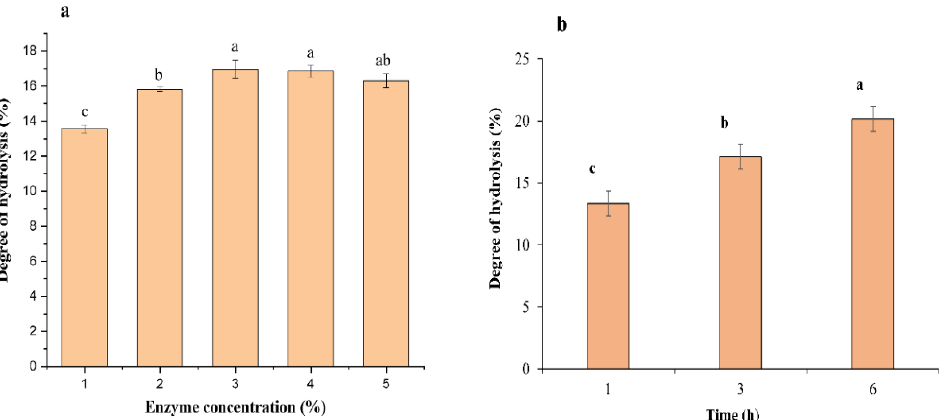
Figure 2. ( a ); Effect of enzyme/substrate ratio, ( b ); hydrolysate production under three different hydrolytic times. Mean ± SD ( n = 3). Different letters indicate significantly different values ( p ≤ 0.05). All results represent the mean of triplicate determinations.